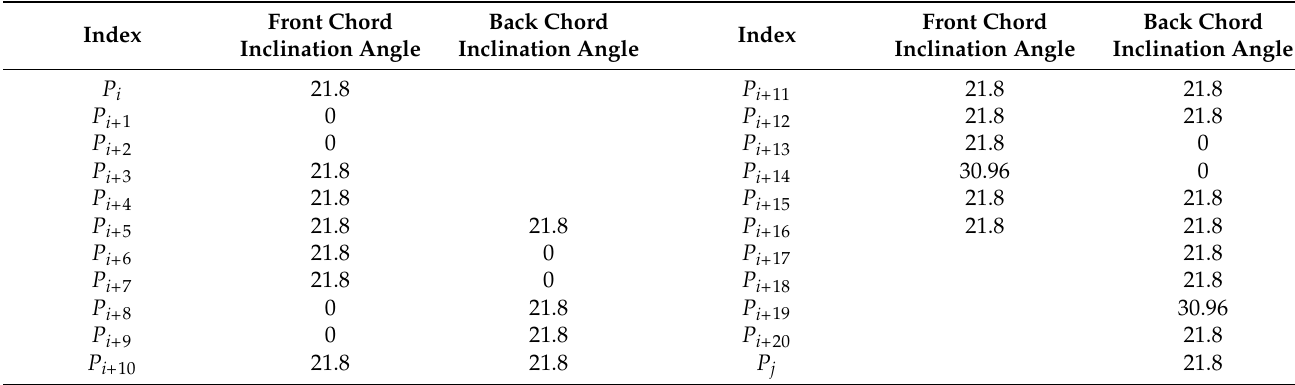
Table 3. Variation in front and back chord inclination angles.